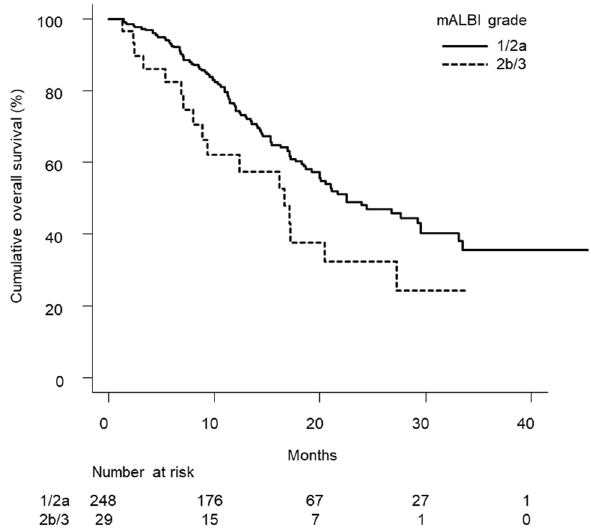
Figure 2. Cumulative survival curves in patients with Child–Pugh score of 5. There was a significant difference in cumulative overall survival between patients with mALBI grades 1/2a and 2b/3 ( p = 0.032). The median survival times in patients with mALBI grades 1/2a and 2b/3 were 22.5 (95%CI, 19.2–29.5) and 16.6 (95%CI, 8.0–27.3) months, respectively.